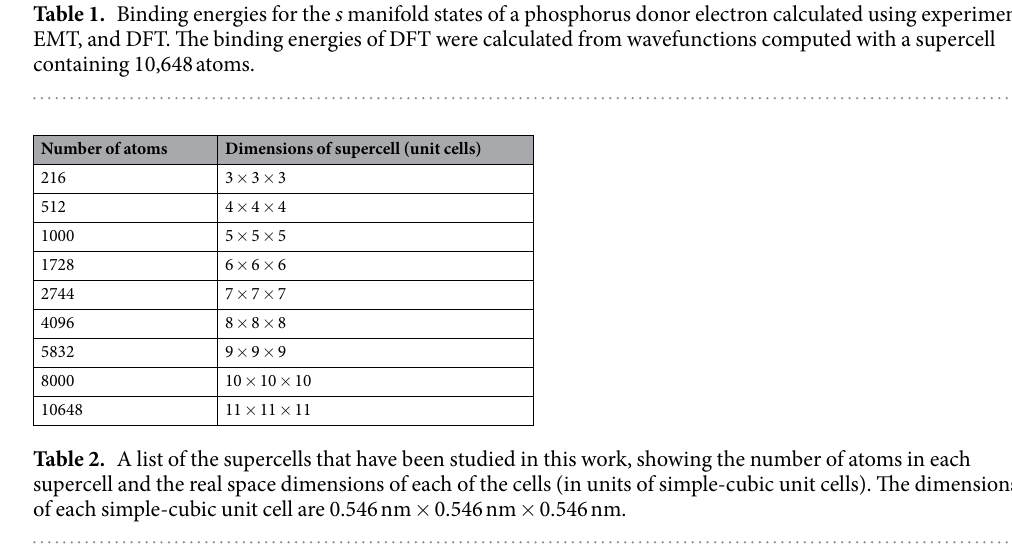
Table 1 presents the binding energies of the s manifold states calculated using experiment, EMT, and DFT. The